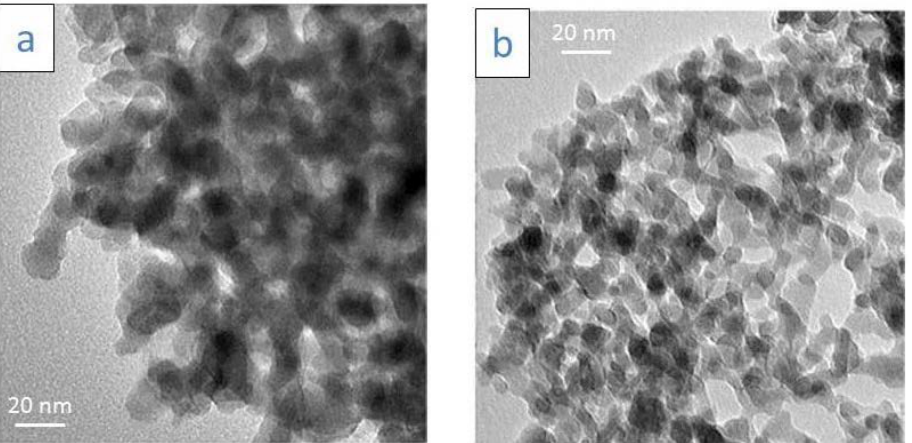
Figure 11. TEM images of Al 2 O 3 /Sm 2 O 3 sol-gel derived materials: ( a ) xerogel and ( b ) aerogel calcined in air at 800 °C for 4 h. (Adapted with permission from [72]. Copyright Springer International Publishing AG, 2015).